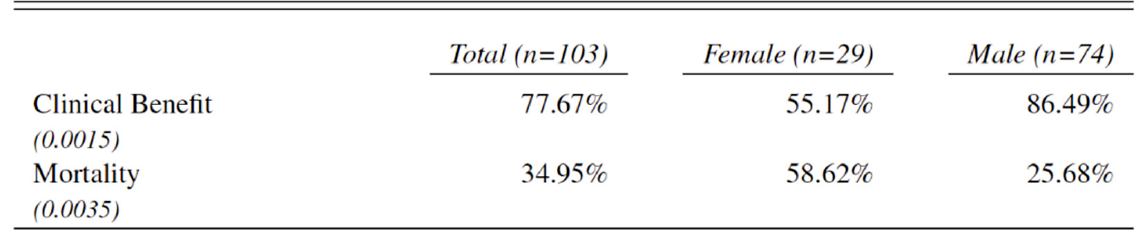
Figure 6. Clinical benefit in all included female and male patients with metastatic melanoma treated with ICI. Clinical benefit being defined as no disease progression displayed on FDG-PET/CT scan six months after initiation of ICI.